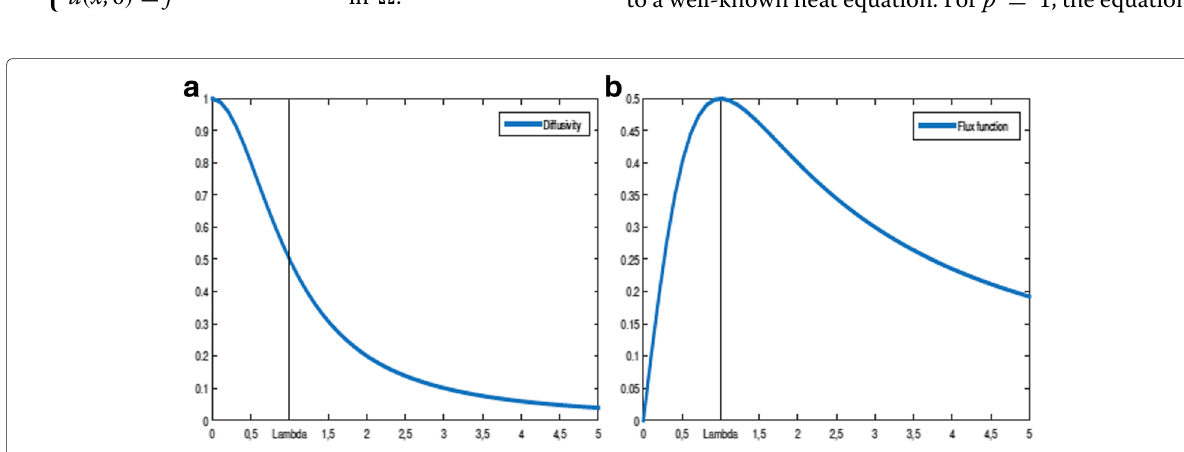
Fig. 1 a Left : diffusivity g ( t ) . b Right : flux function (cid:6)( t